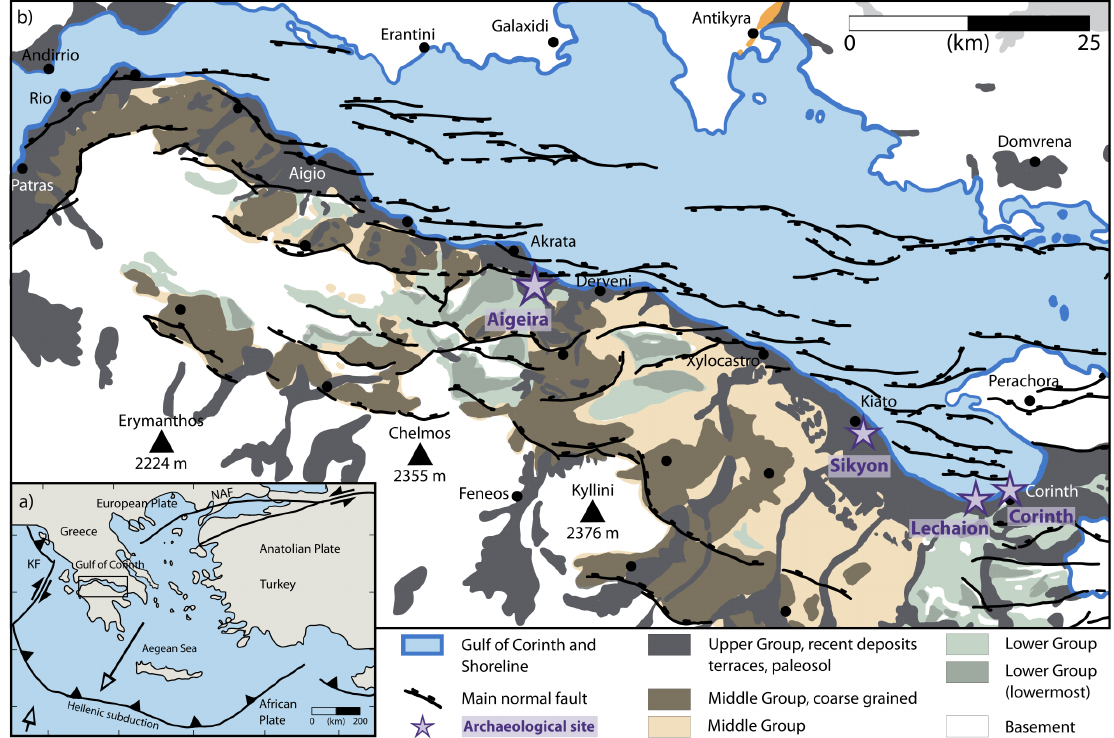
Figure 2. ( a ) General regional tectonic setting (after [14]). ( b ) Geological map of the syn-rift sediments after [33]. Marked are also the location of the archaeological sites mentioned in this